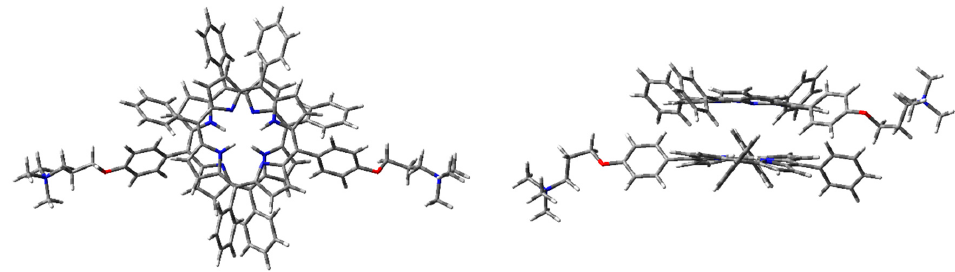
Figure 9. 1H 2 H-dimer geometry optimization in the vacuum with WB97XD functional and 6-31G(d) basis set: front ( left ) and side view ( right ).